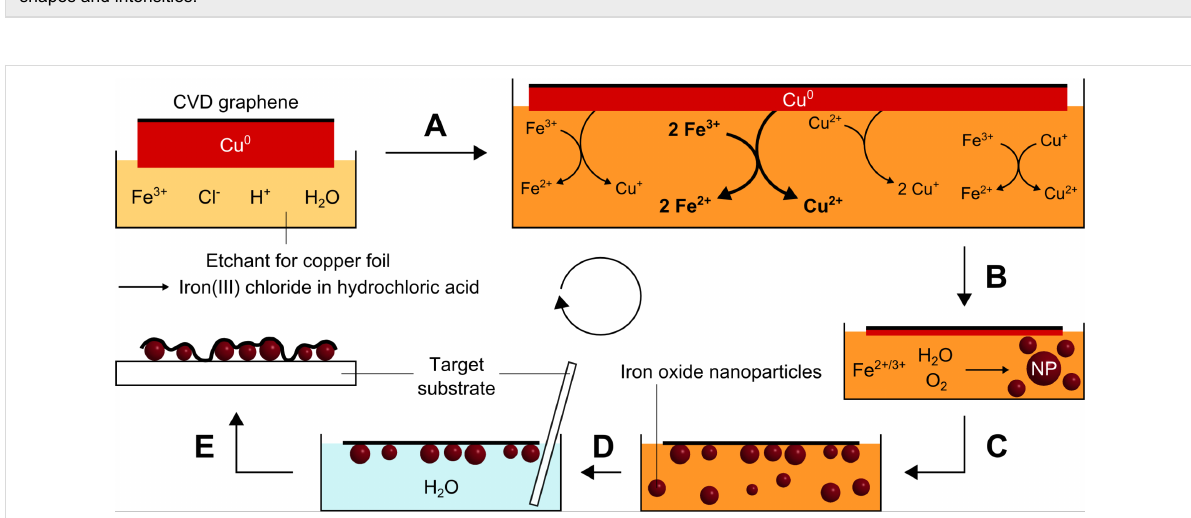
Figure 3: Schematic of the proposed mechanism for the formation of iron oxide nanoparticles on graphene during the modified transfer of graphene by chemical etching. (A) Etching of copper using a hydrochloric solution of iron(III) chloride. (B) Formation of iron oxide nanoparticles. (C) Adsorption of nanoparticles on CVD graphene. (D) Cleaning of graphene and removal of free nanoparticles by dilution with water. (E) Transfer of the as-functio- nalized CVD graphene onto a target substrate.